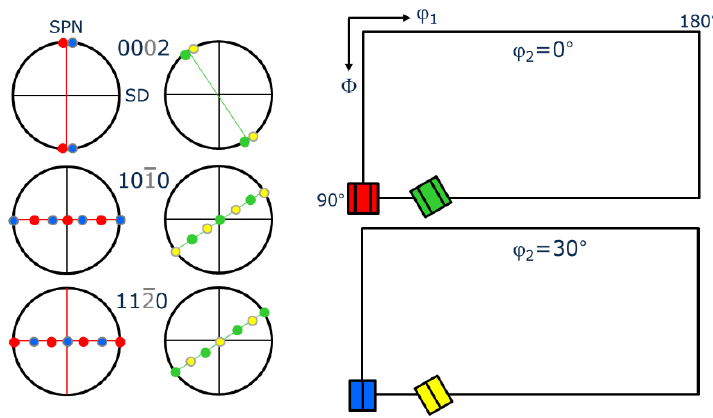
Figure 13. Key figure of shear texture components of HPT deformed hcp phase ( right ) and their crystallographic description with regard to shear plane and shear direction ( left ).